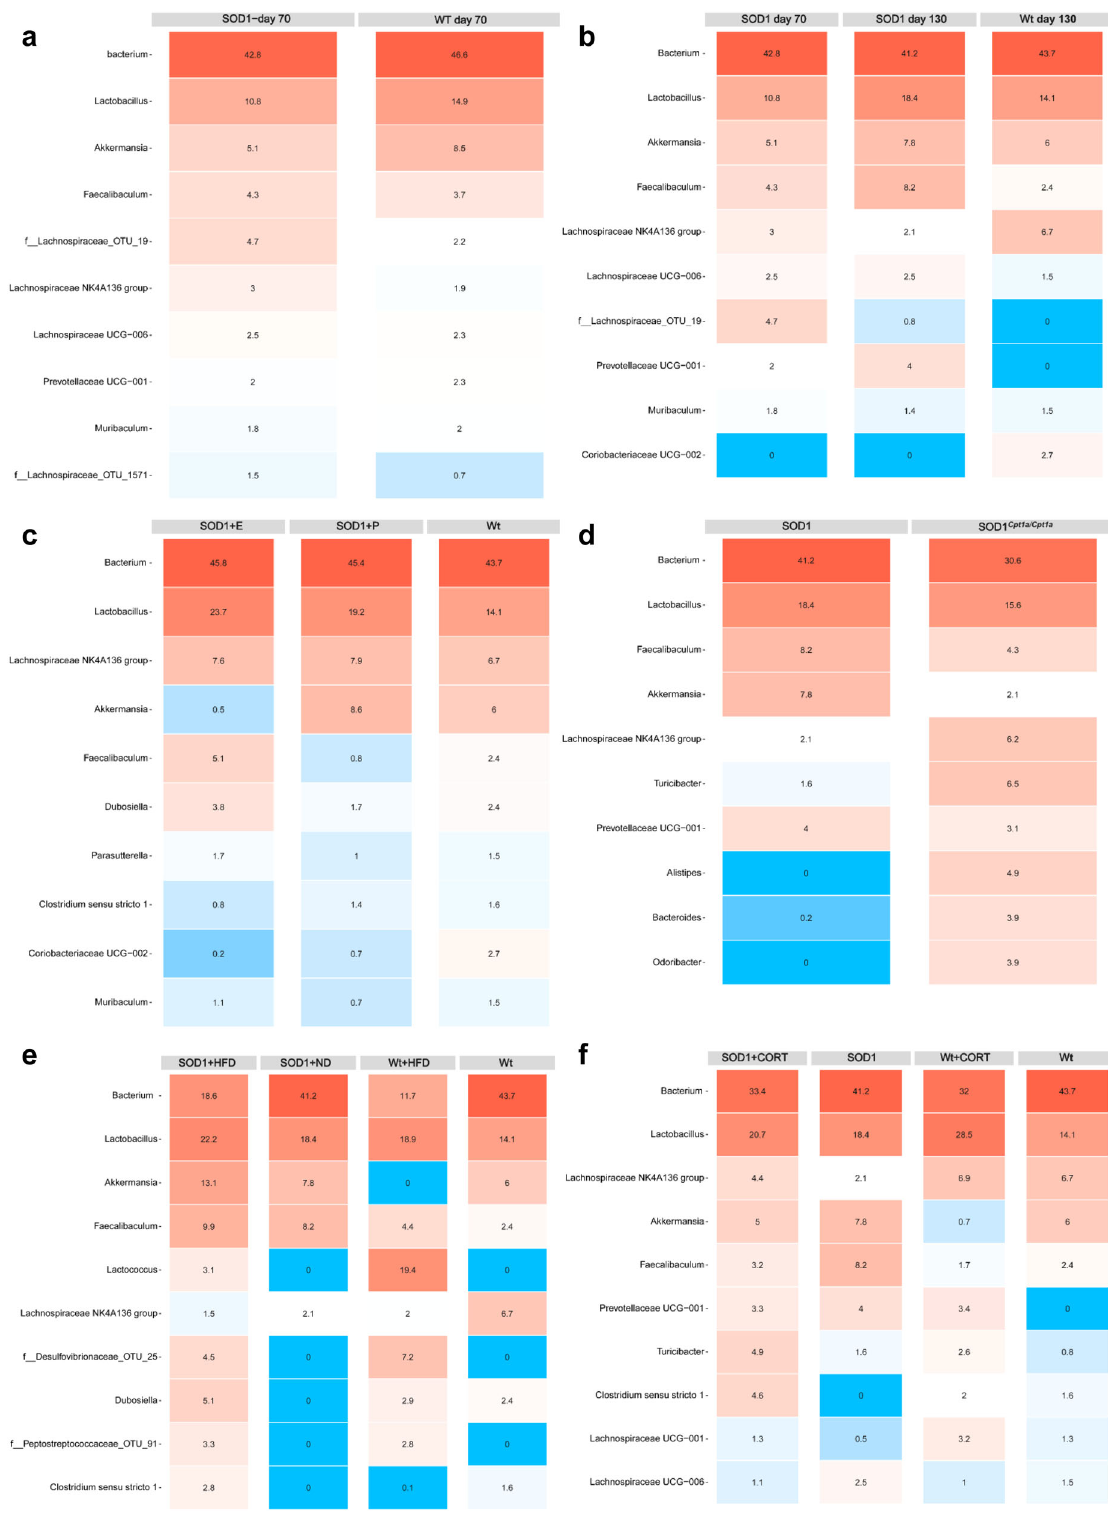
SOD1 male mice with female C57Bl/6J mice. Litters were genotyped according to established protocol using DNA extracted from ear tissue punches 80 . Male SOD1 mice were used to maintain the colony, and SOD1 female and their wildtype littermates were used for experiments. All animals were assessed for human end- points daily, weight twice a week, and neurological score once a week. SOD1 males ( n = 9) and females ( n = 5) were evaluated by neurological score, grip strength, hangwire test and y-maze test at day 140 to evaluate differences between the males and females as described under clinical behavioral tests. In addition, survival